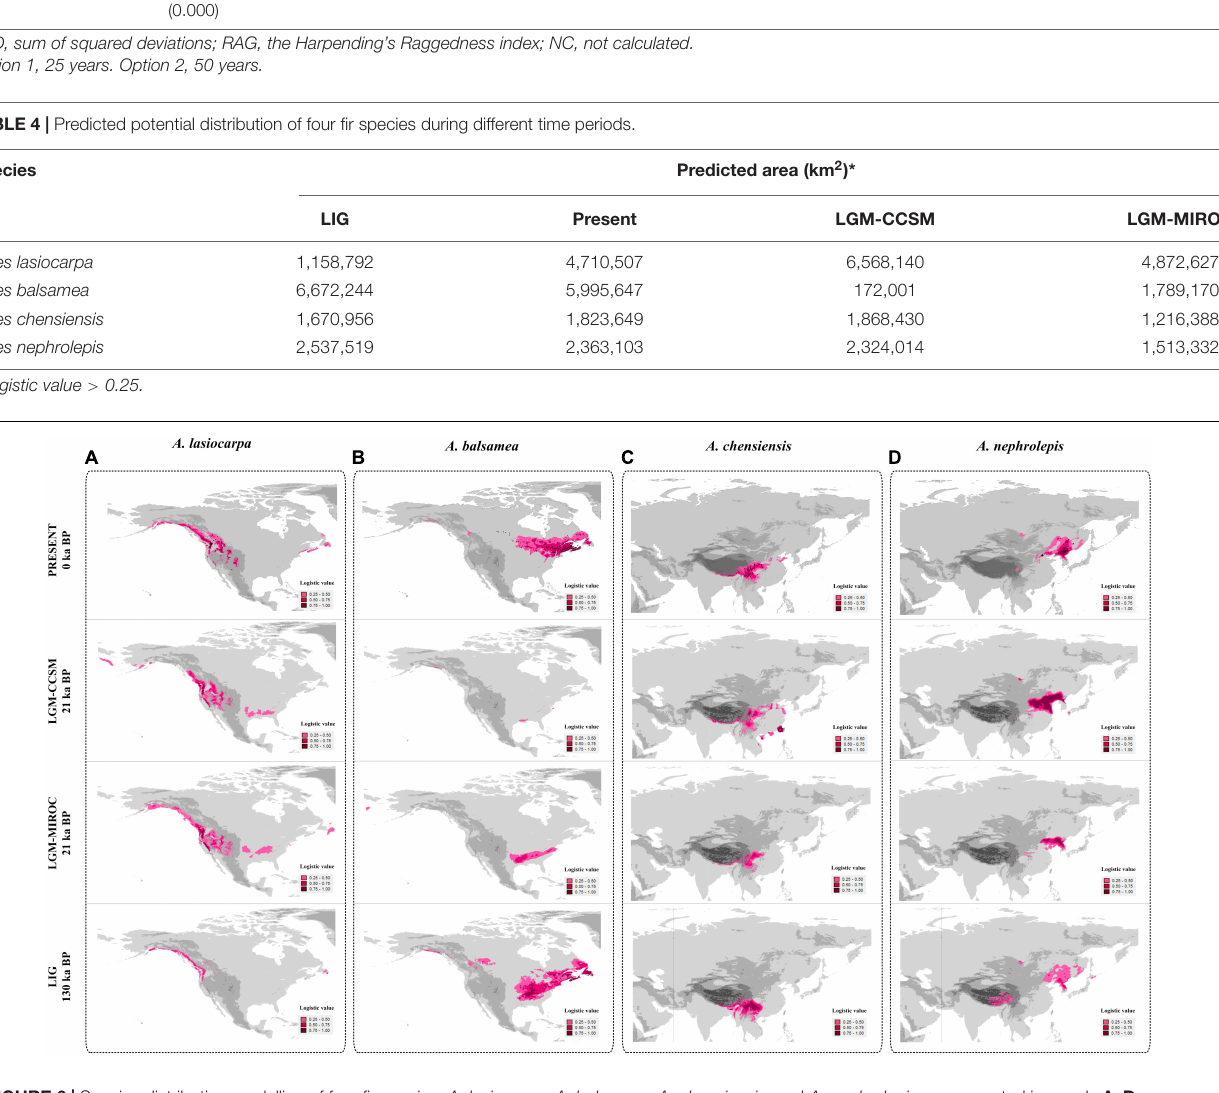
FIGURE 6 | Species distribution modelling of four fir species. A. lasiocarpa, A. balsamea , A. chensiensis , and A. nephrolepis are presented in panels A–D , respectively. Black dots presents the occurrence records used in the